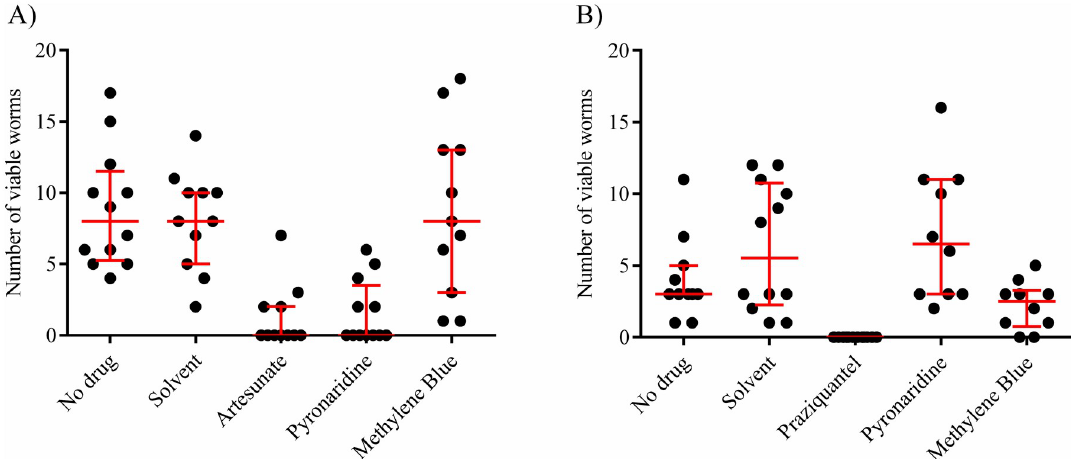
Fig 2. Drug activity in S . mansoni -infected mice (step 3). Mice were treated with respective compounds after A) 14 days (juvenile worms) and B) 9 weeks (adult worms) of S . mansoni infection, respectively. Mice were killed and adult worms were recovered and counted. MB: methylene blue, PY: pyronaridine, AS: artesunate, PZQ: praziquantel. Each data point (filled circle) represents one mouse. Thick bar: median, whiskers: IQR. A statistically significant difference (P < 0.05) to no drug control was detected for A) AS and PY, and for B) PZQ, respectively. Results from two independent experiments are shown for A and from one experiment for B.